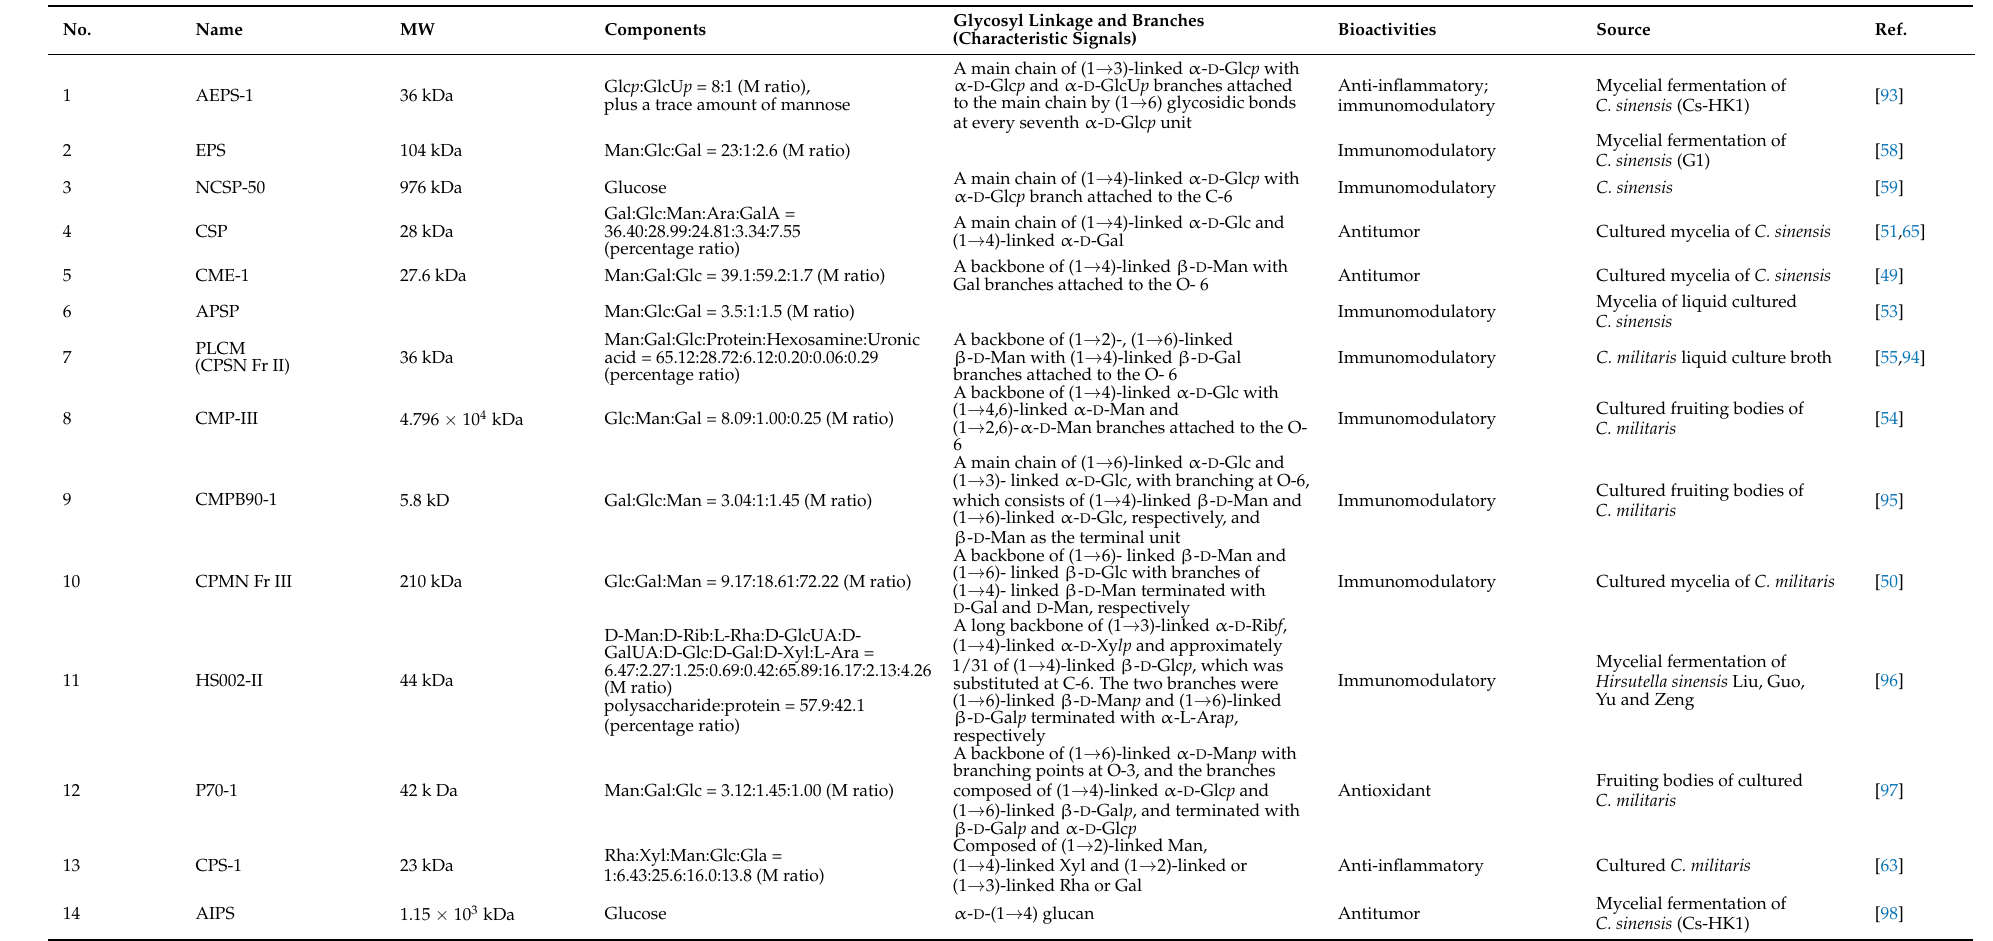
Table 2. Polysaccharides that originated from Cordyceps spp.: chemical structure and immunomodulatory and antitumor